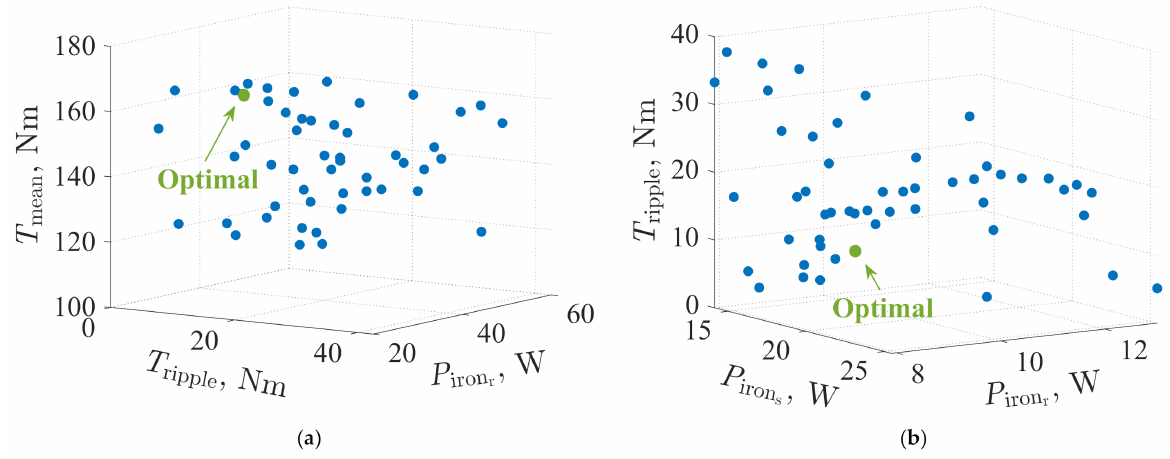
Figure 11. Optimization results of the three objectives for the asymmetrical six-phase machine under various operational modes: ( a ) Propulsion and ( b ) charging.